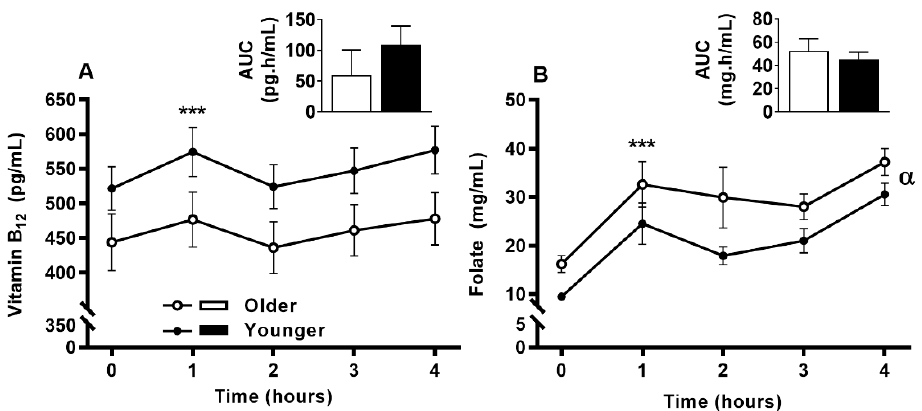
Figure 2. Serum ( A ) vitamin B 12 and ( B ) folate at fasting (time, 0), hourly until 4 h (time, 1, 2, 3, 4) and the four hour incremental area under the curve (AUC, represented by bar-graphs) following a single multivitamin and mineral supplement ingestion in older and younger adults. Data for multiple time points was compared using general linear mixed model with time as repeated and age as fixed factor. AUC data was compared with general linear univariate analysis of variance with age as fixed factor. There was a main time e ff ect for serum vitamin B 12 concentration ( p < 0.001) and main time ( p < 0.001) and main age e ff ect ( p = 0.022) for serum folate. Both vitamin B 12 and folate AUC were not di ff erent between age groups. ***, p < 0.001, significant increase following supplement intake relative to baseline in both age groups; α , p < 0.05, main age effect.